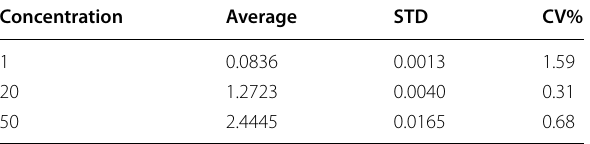
Table 1 Intermediary precision for the analytical method to determine the pheromone rhynchophorol